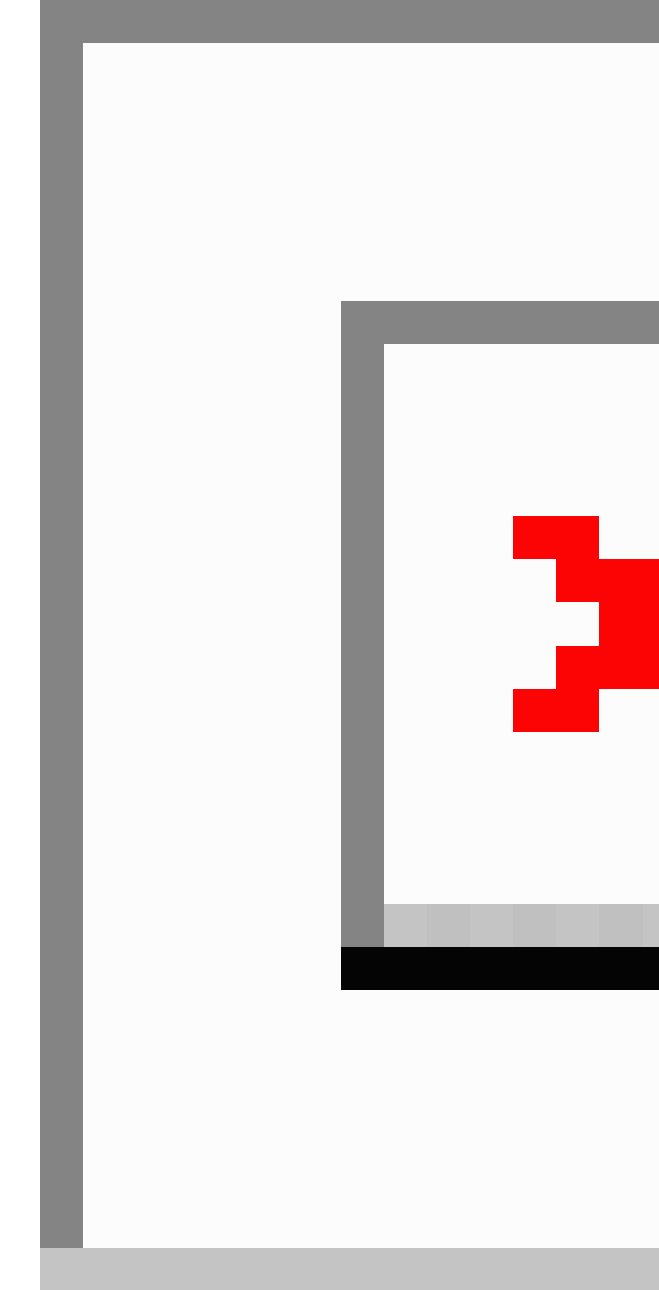
Figure 2. Demographic overview of the survey